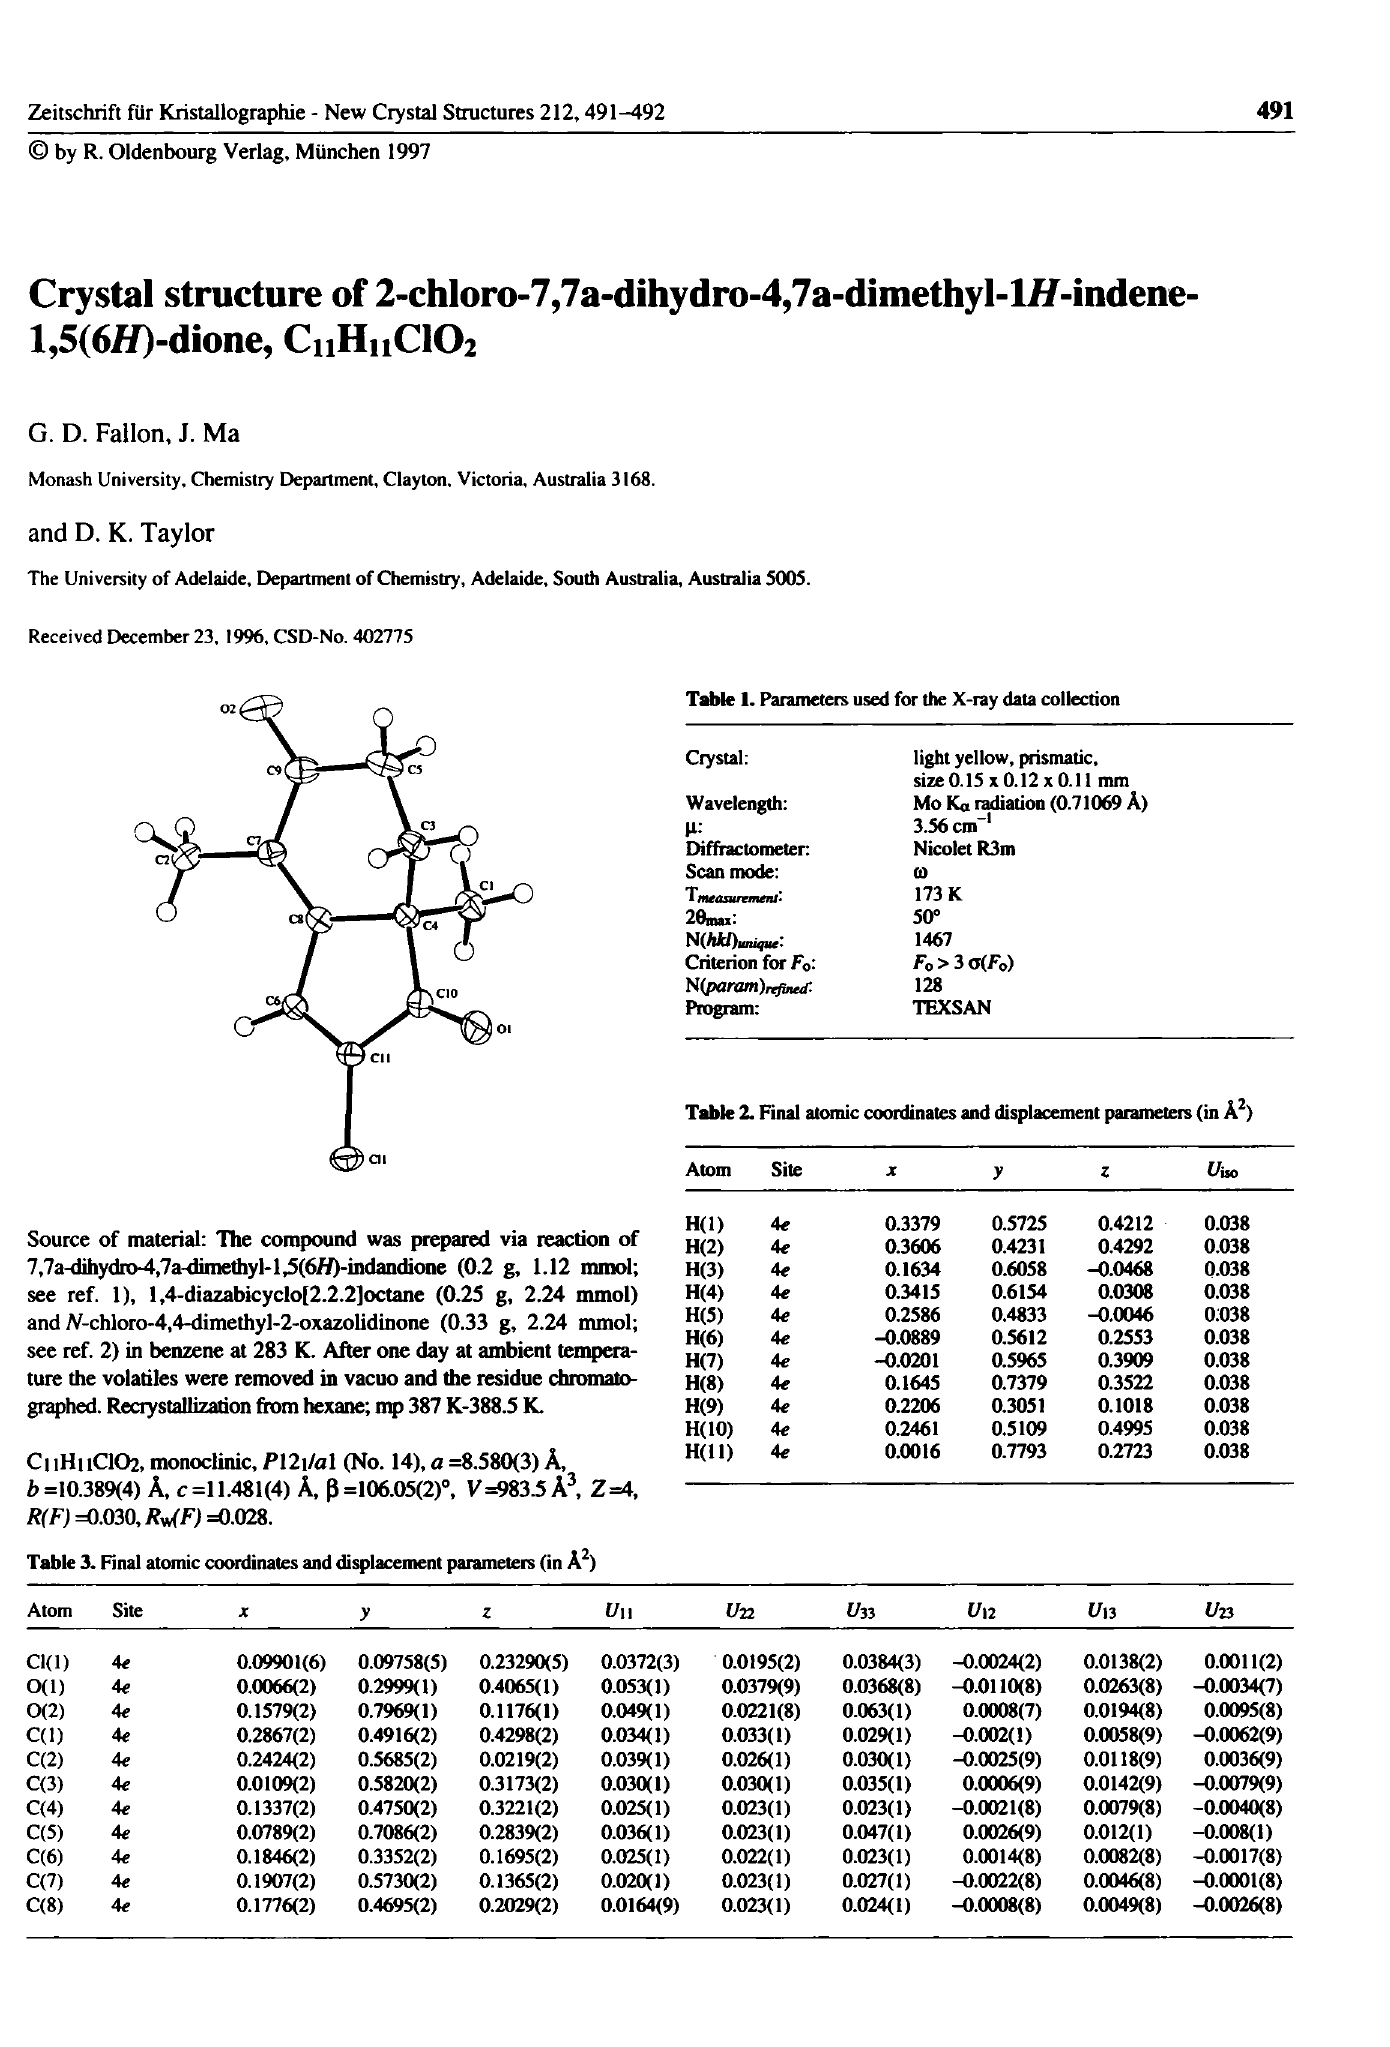
Table 1. Parameters used for the X-ray data collection